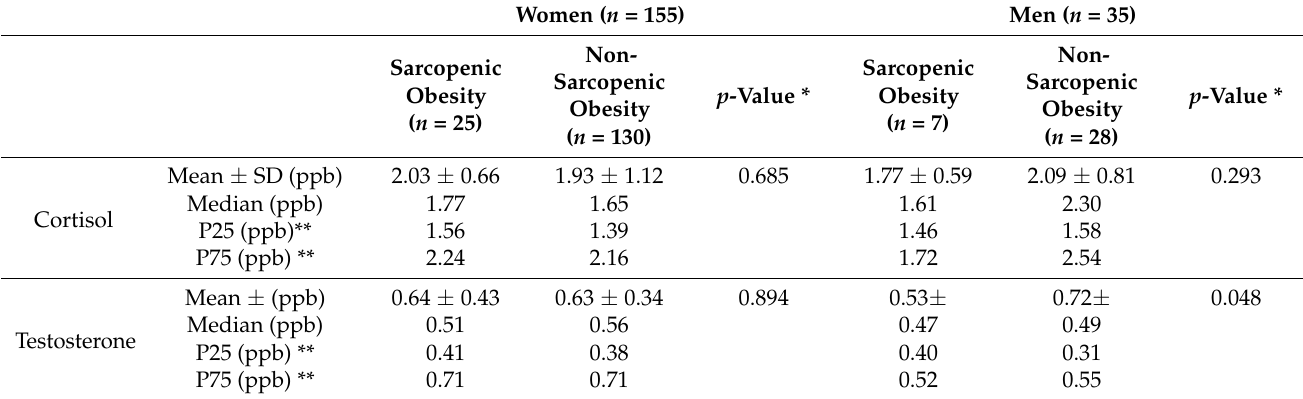
Table 5. Descriptive values for salivary cortisol and testosterone by sarcopenic obesity